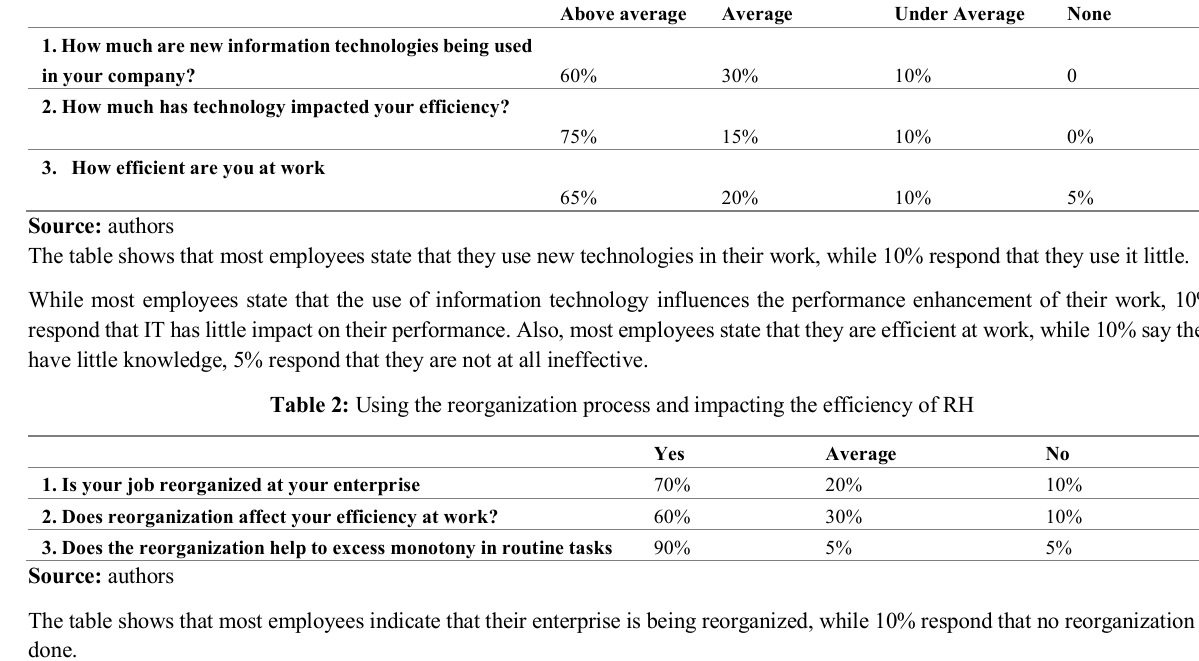
Table 1: The use of new technologies from the enterprises and their impact in efficiency of HR Above average Average Under Average